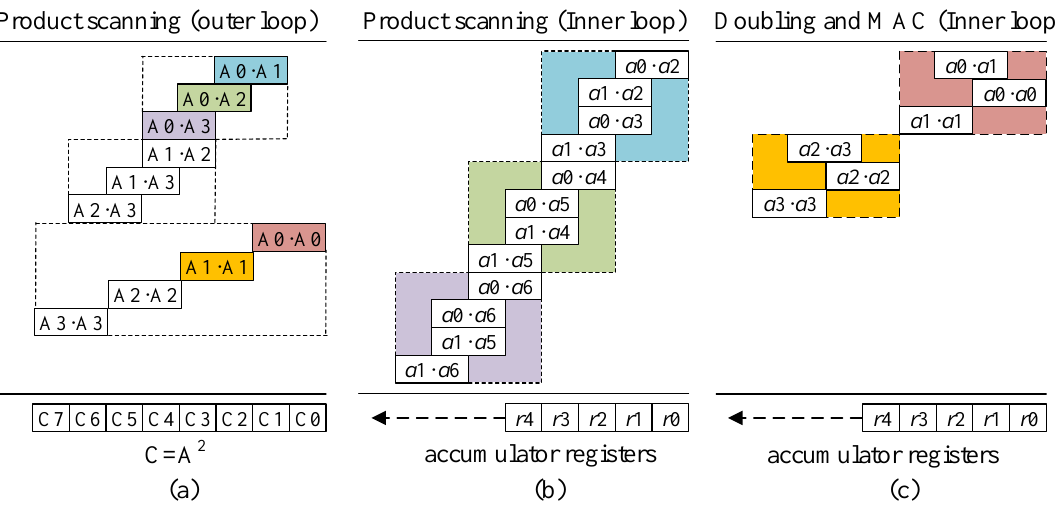
Figure 3. The proposed product-scanning squaring. ( a ) outer loop, an example of 128-bit squaring. ( b ) inner loop, product scanning, ( A 0 · A 0, A 0 · A 2, A 0 · A 3). ( c ) inner loop, doubling and MAC, ( A 0 · A